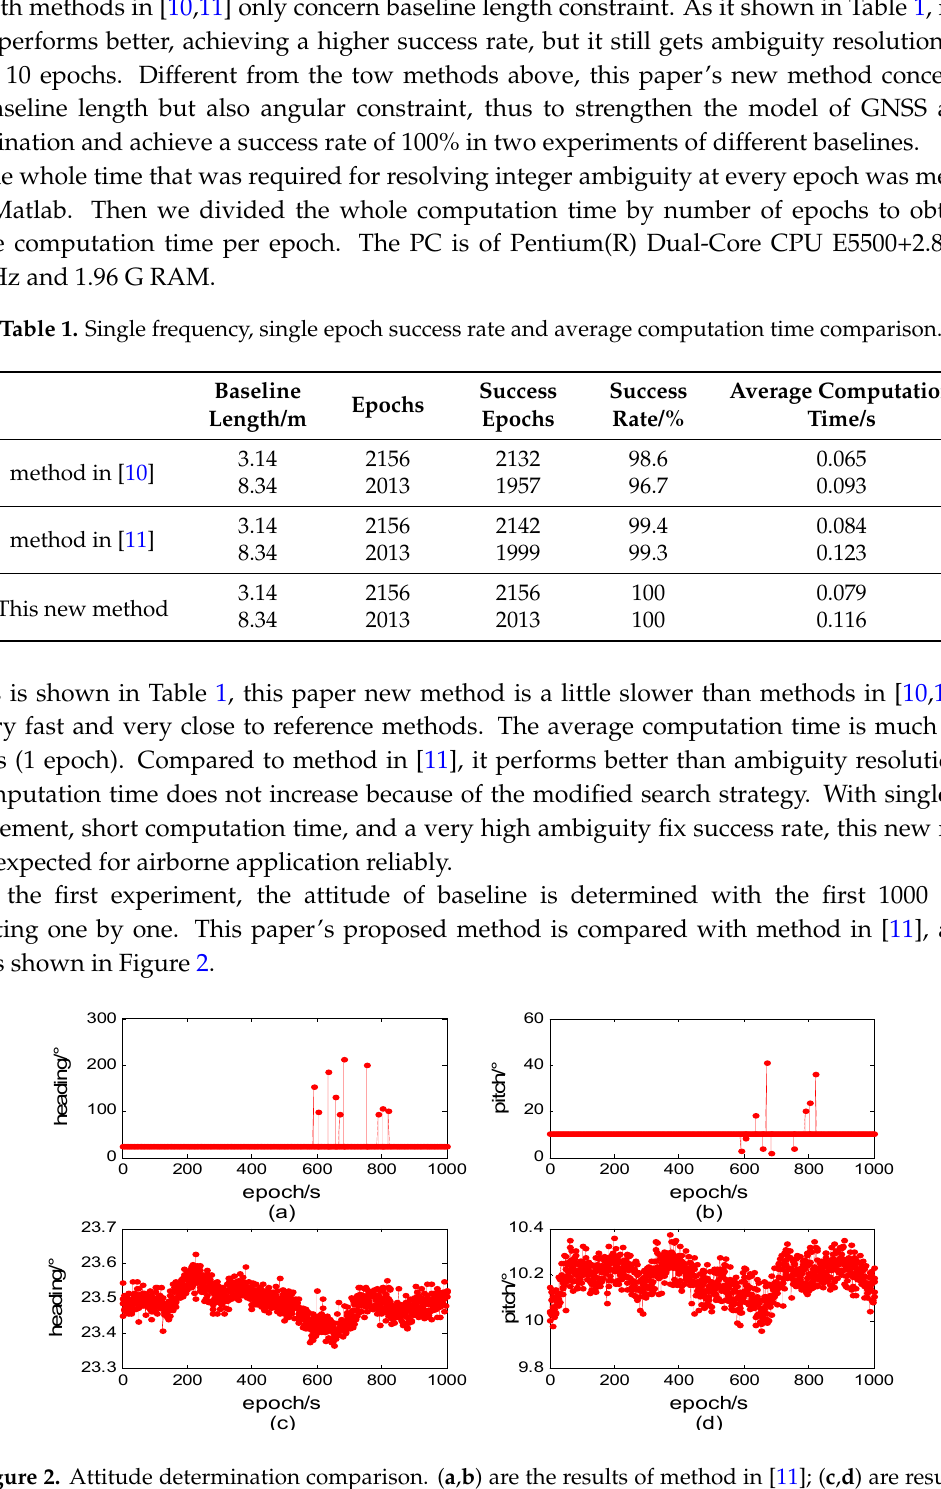
Figure 2. Attitude determination comparison. ( a , b ) are the results of method in [11]; ( c , d ) are results of new method.